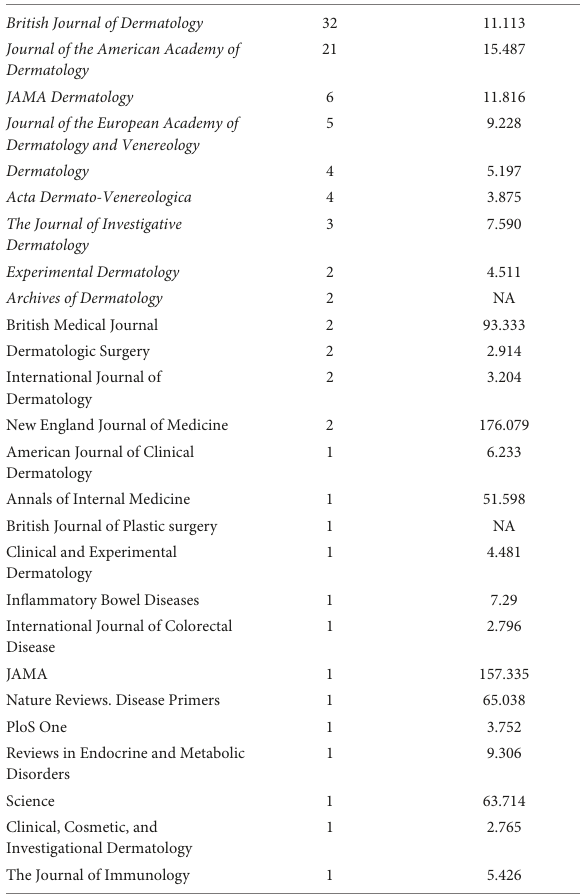
TABLE 1 Journal names for the top 100 most-cited publications in hidradenitis suppurativa stratified by number of articles in the top in descending order; impact factors from 2021 are also